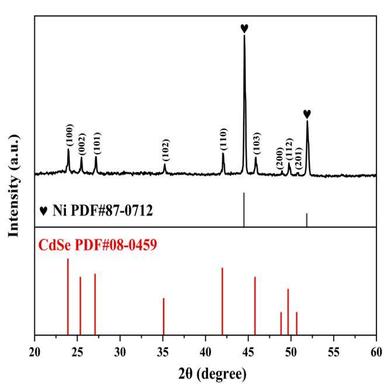
XRD patterns of CdSe materials.